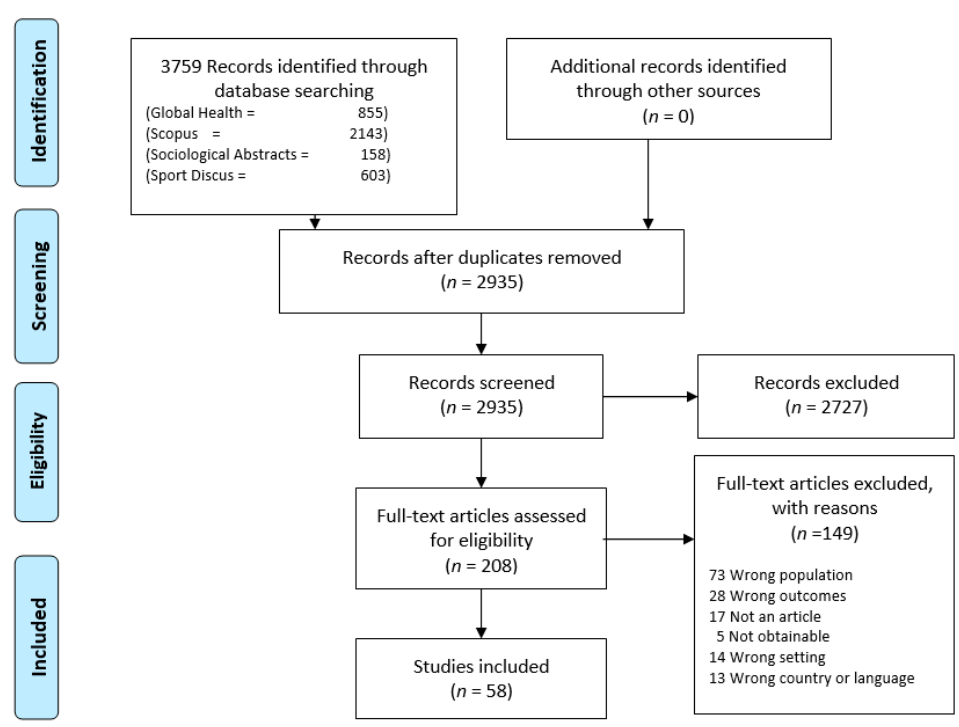
Figure 1. Flowchart of search results.